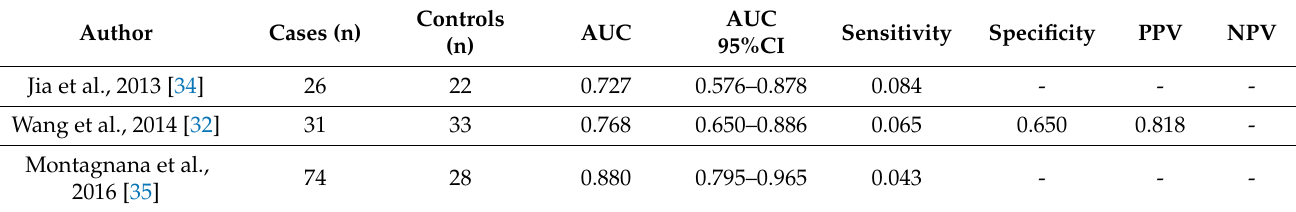
Table 4. Summary table of the performance of Micro-RNA